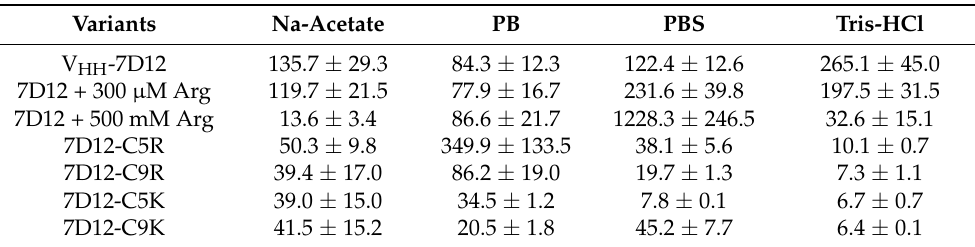
Figure 5. Size of sub-visible aggregates formed upon 75 °C heat incubation. The presence of sub- visible aggregates was analyzed by measuring the Z-ave hydrodynamic radius ( R h) using dynamic light scattering (DLS). After 75 °C heat incubation, the samples were centrifuged, and 100 µL of the supernatant was used for DLS measurement at 25 °C. The R h of V HH -7D12 variants in ( A ) 20 mM Na-acetate buffer ( B ) 20 mM phosphate buffer ( C ) PBS and ( D ) 20 mM Tris-HCl. Table 3. Z-ave hydrodynamic radius ( R h , nm) at 25 ◦ C of V HH variants in the supernatant after 75 ◦ C heat